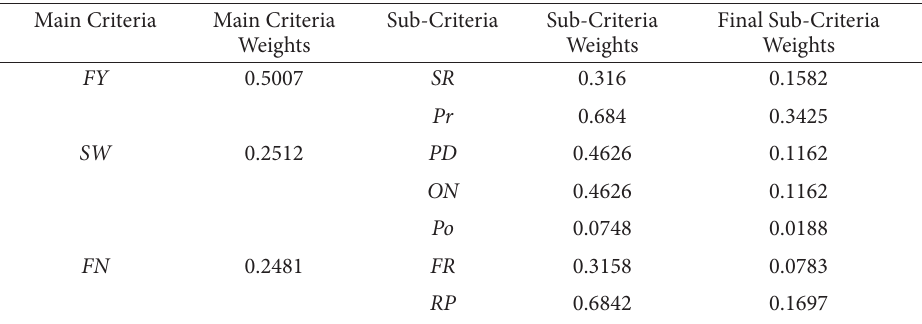
Table 2. Criteria weights for risk level of a vendor Main